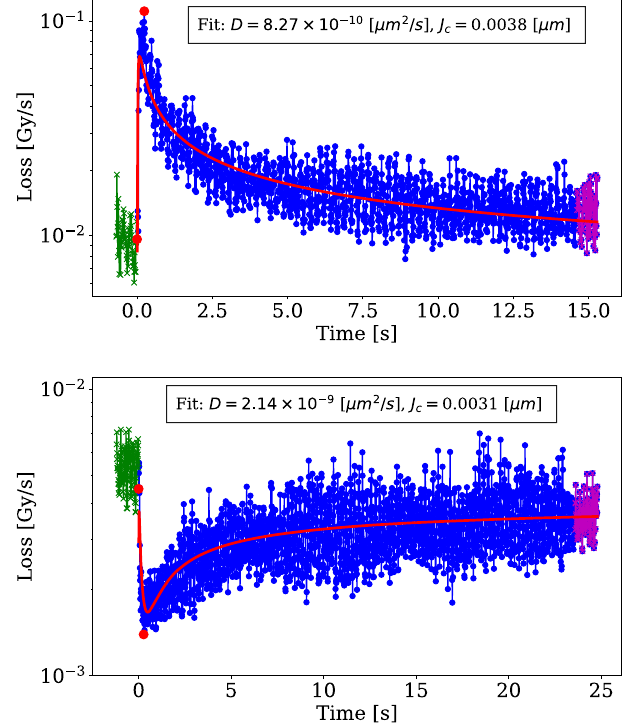
FIG. 5. Two examples for recorded data (blue) and fit results (red) for one of the inward steps by 5 μ m (top) and outward step by 20 μ m (bottom) step analysis. Highlighted green and magenta regions were used to establish the initial ( A level. Examples from fill 6052 are reported in Table III.